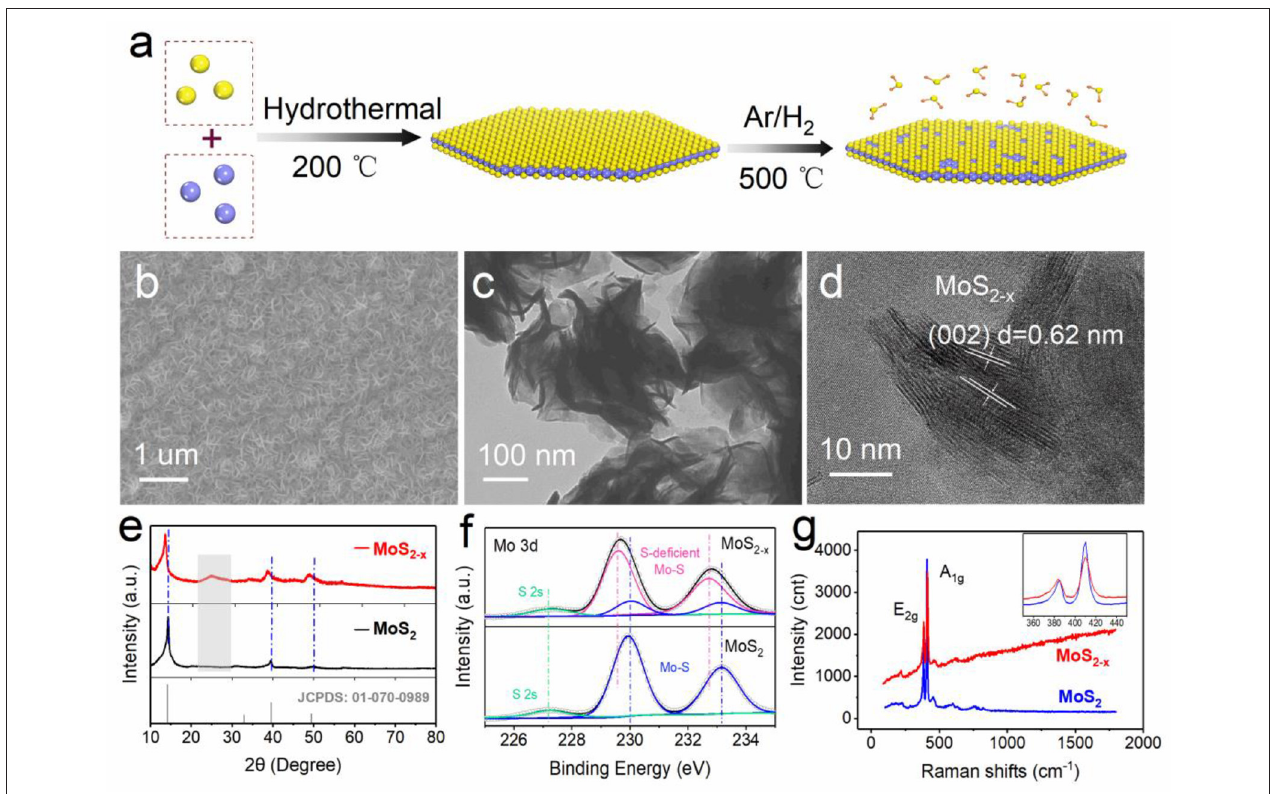
FIGURE 1 | Material synthesis and characterization. (a) Schematic of the synthesis. (b) SEM image of MoS 2 − x on carbon paper. (c) TEM image of MoS 2 − x . (d) High-resolution TEM of MoS 2 − x . (e) XRD patterns of MoS 2 − x and MoS 2 . (f) XPS core-level Mo 3d spectra from MoS 2 − x and MoS 2 . (g) Raman spectra of MoS 2 − x and MoS 2